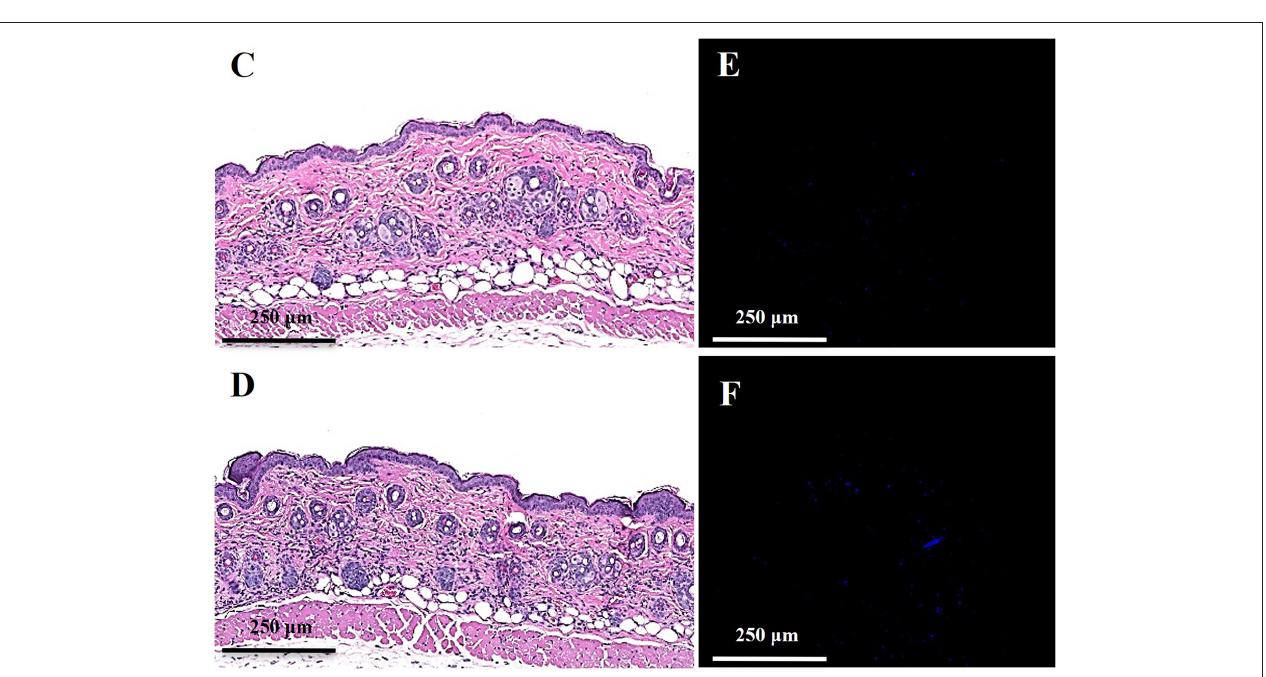
FIGURE 6 | Toxicity evaluation of oregano oil to normal mouse skins. The dorsal skin of mice was topically treated with (A,C,E) or without 10 mg/ml oregano oil (B,D,F) once a day for three consecutive days. On day 4, the skins were photographed (A,B) , followed by histological examination (C,D) . The skin sections were also TUNEL stained (E,F) . DNase I treated skin samples (G) were TUNEL stained in parallel as positive-staining controls.